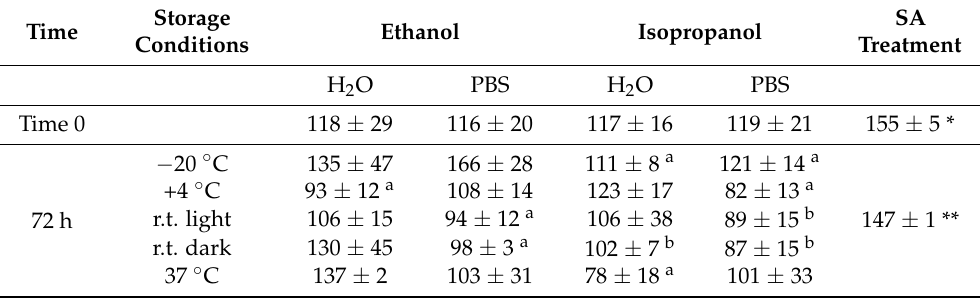
Table 1. Analysis of the protective effect of açai extract on ROS levels in HaCaT cells stressed by sodium arsenite (SA). Results are expressed as percentage of ROS in treated cells with respect to untreated cells. ND, not determined. Data shown are means ± S.D. of three independent experiments. * p < 0.05 with respect to control cells prior SA treatment; ** p < 0.01 with respect to control cells